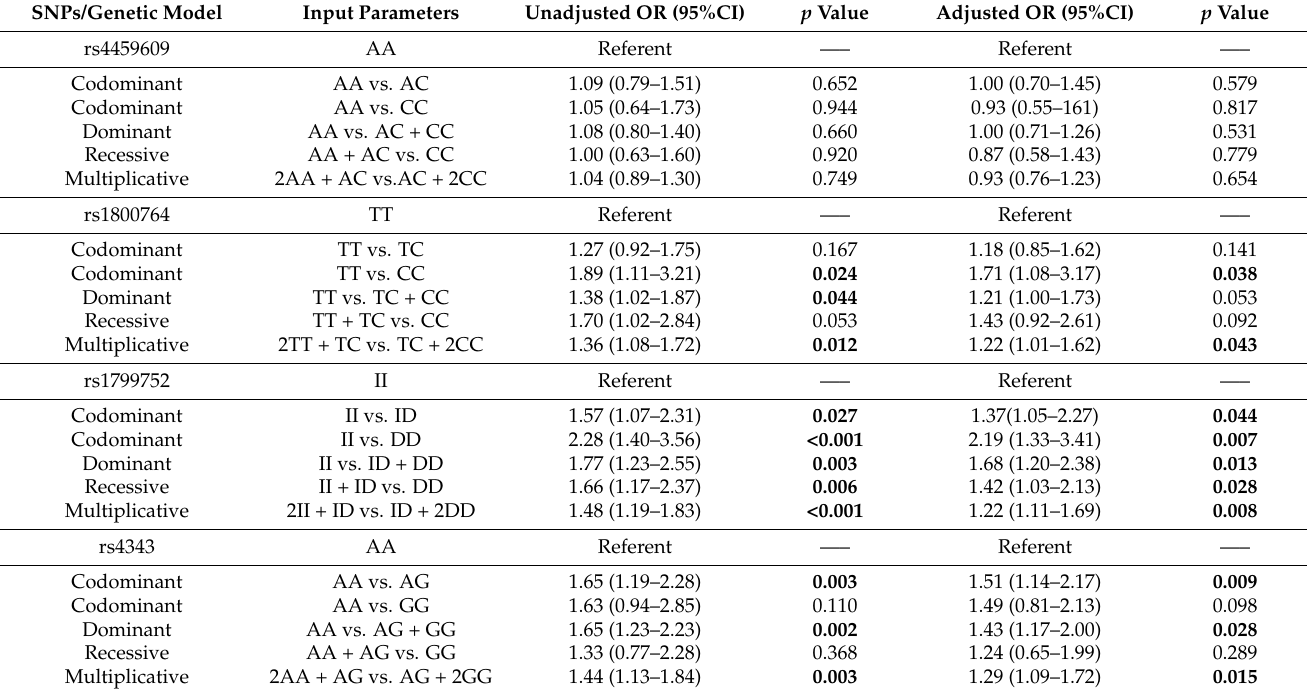
Table 4. Association of ACE gene SNPs for the endothelial dysfunction associated osteoporosis risk. SNPs/Genetic